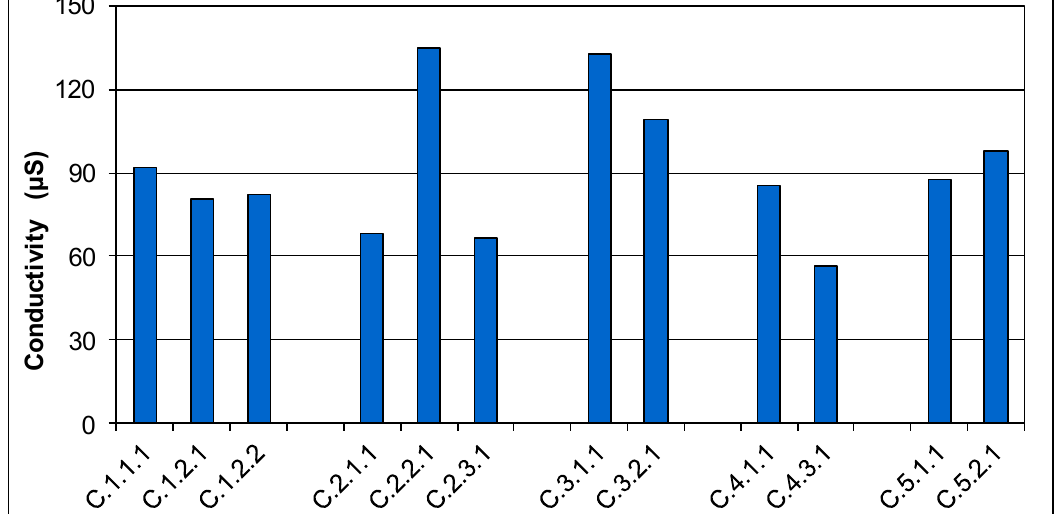
Figure 7. Histogram with the data about the